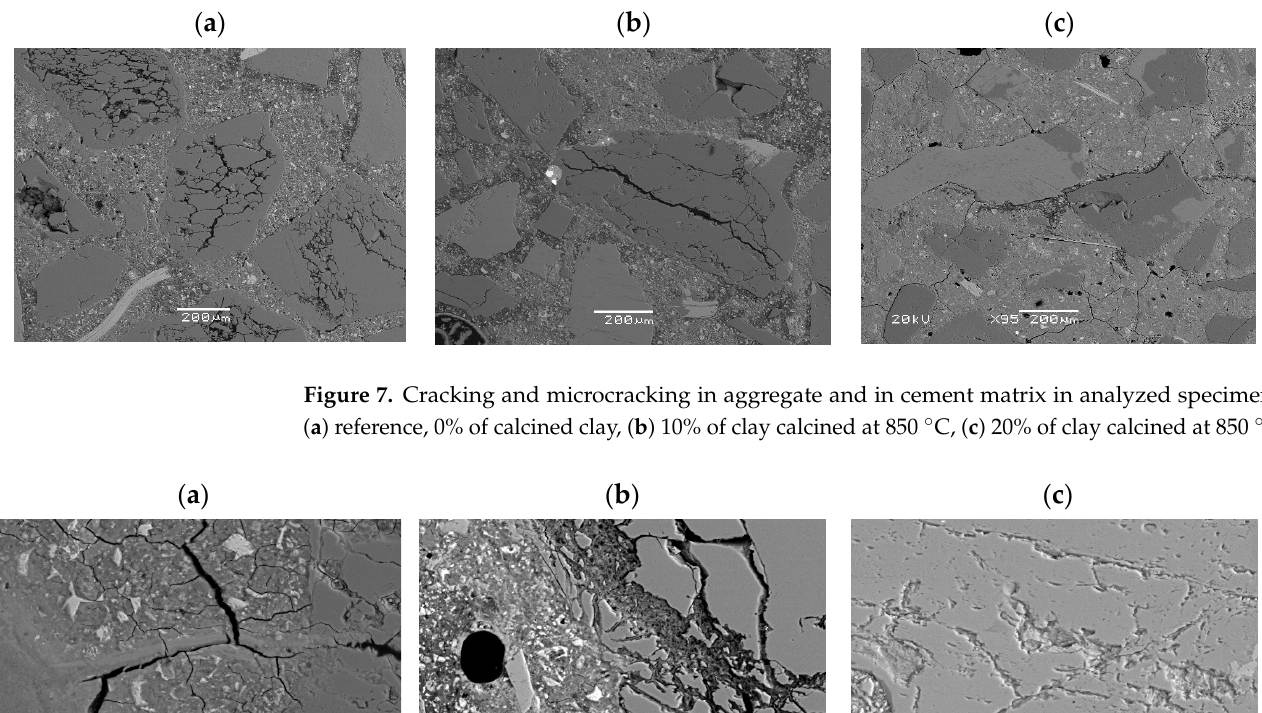
Figure 6. Results of the SSA of the calcined clay determined by BET method and expansion according to ASTM C1567 depending on calcination temperature.